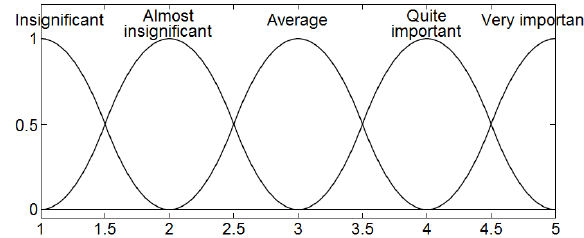
Figure 1: Membership function for the input variable x 1 – PR(Uph) , polygonal functions (piecewise linear)